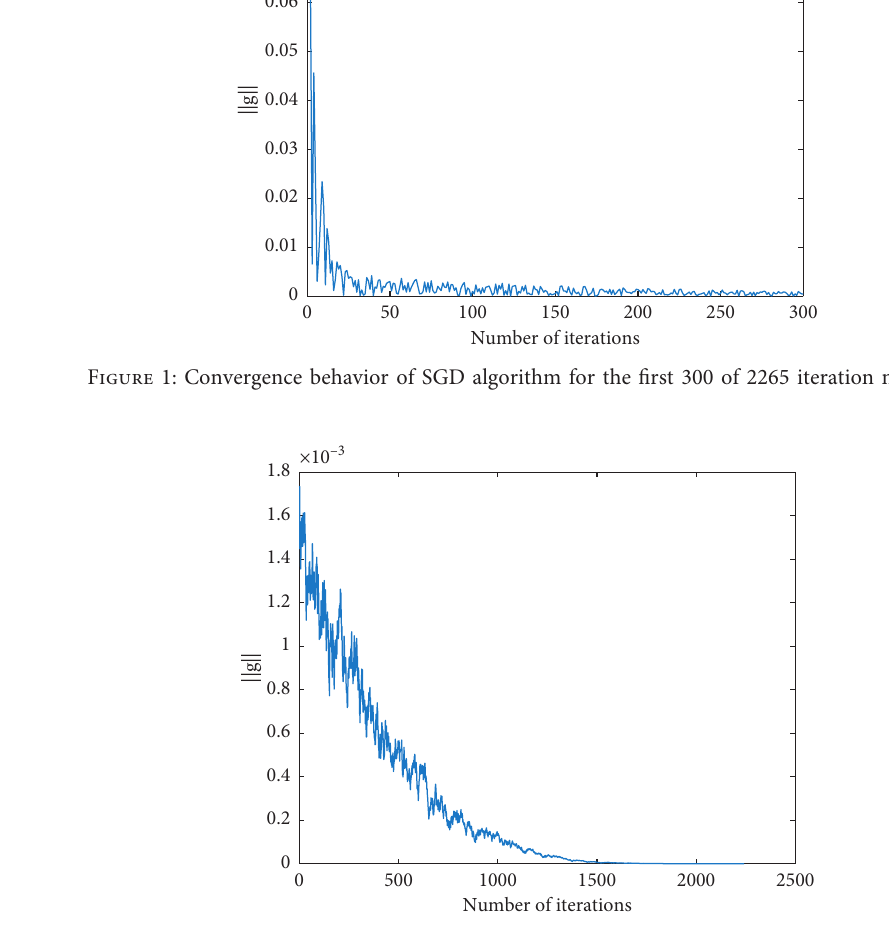
Figure 2: Convergence behavior of Adam algorithm.